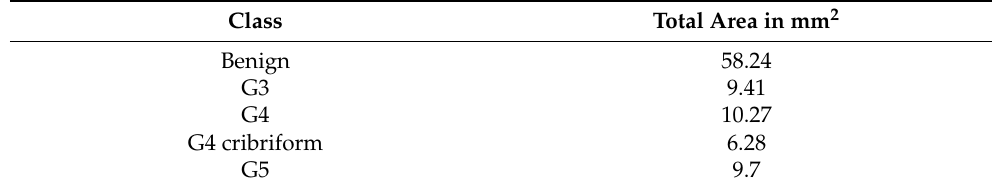
Table 3. Total area per annotated class in the training set of 516 biopsy slides.